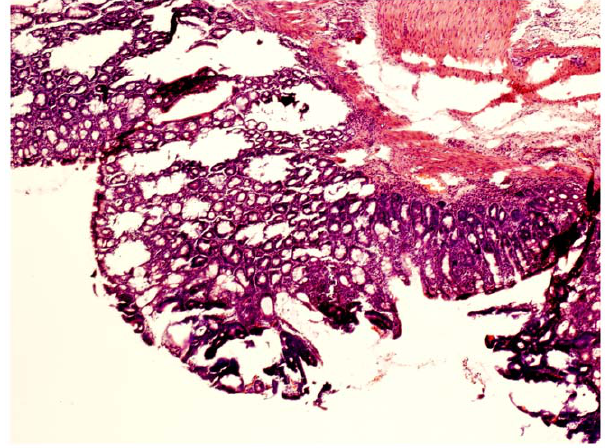
Figure 4. Dysplasia-associated lesion. Colonic mucosa showing a dysplastic lesion in association with inflammation. The sample was taken from an animal in group C.